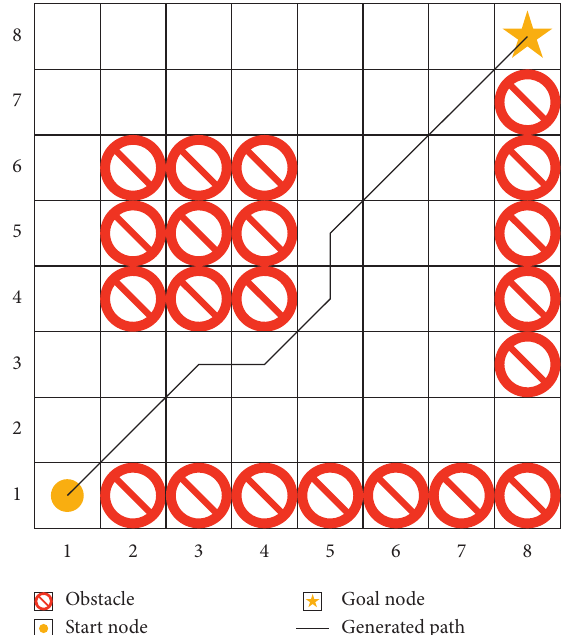
Figure 1: An example of the grid map and optimization path generated by traditional A ∗